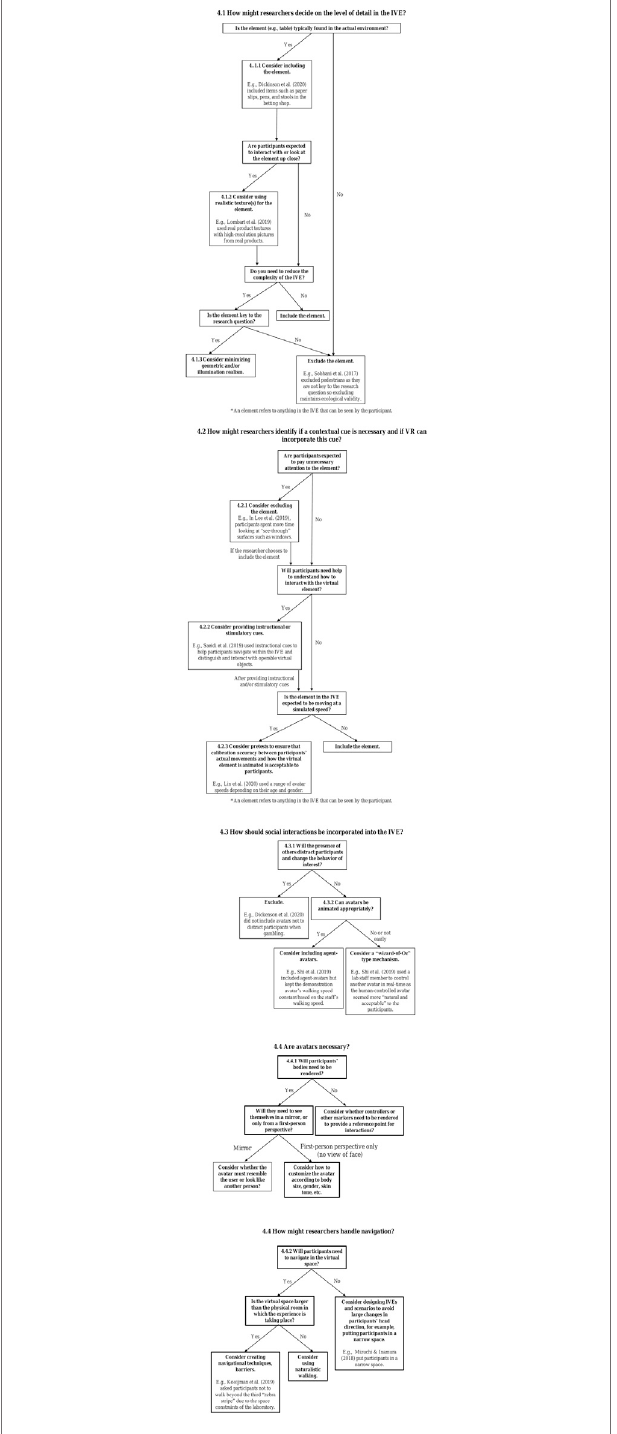
FIGURE 4 | Flow diagrams summarizing the strategies for the design of IVEs to understand environments ’ in fl uence on behaviors.